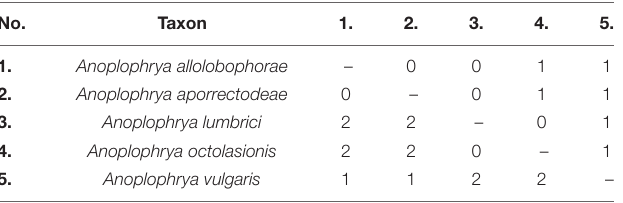
CBCs, compensatory base changes.